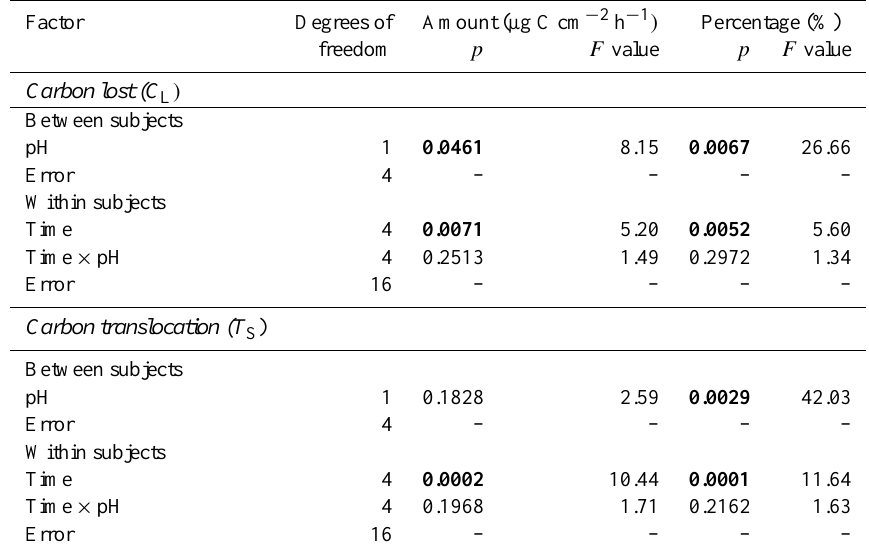
Table 4. Results of the repeated measures analysis of variance (ANOVA) testing the effect of pH and incubation time on the amount and percentage of carbon lost ( C L ) and translocated ( T S ) . Significant p values are in bold.